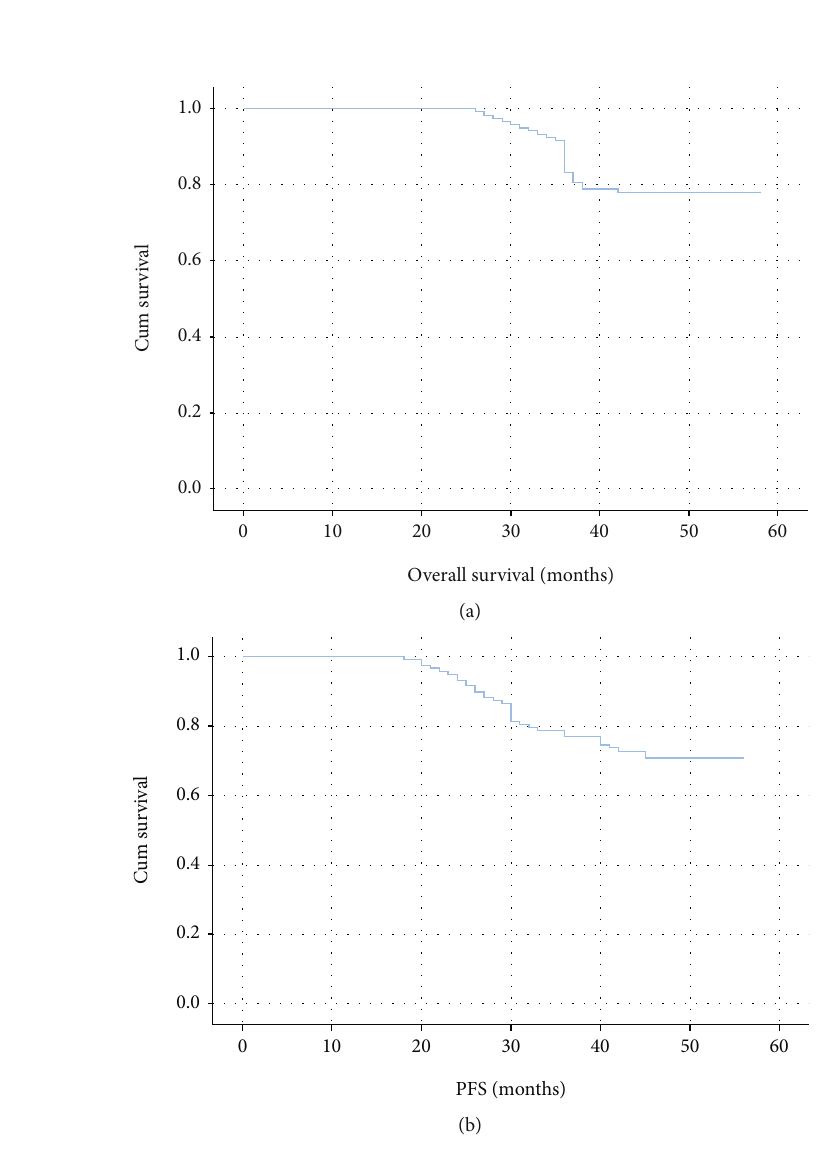
Figure 3: (a) Overall survival among all cases and (b) overall progression-free